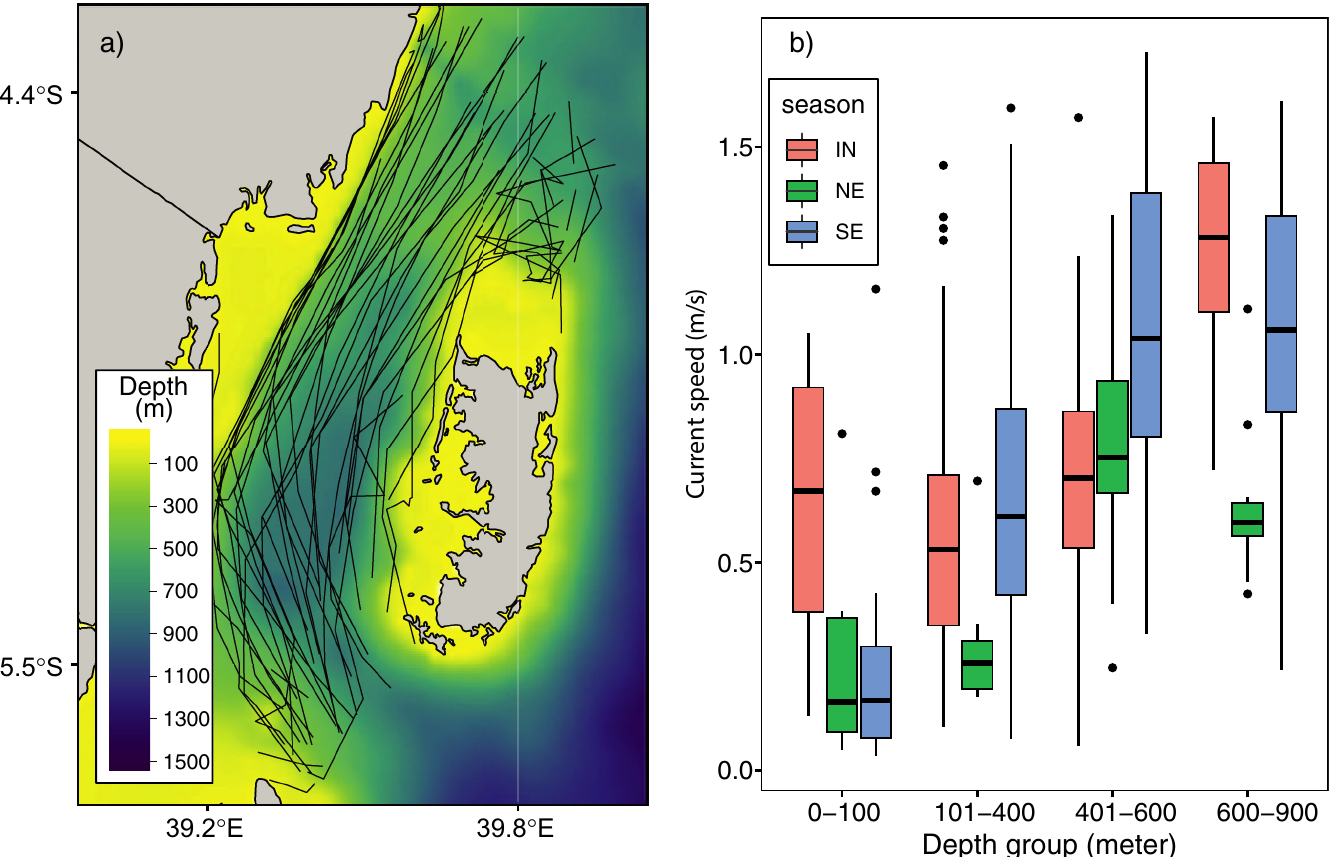
Fig 6. A map of the Pemba Channel showing a) the relationship between the drifter trajectories and bathymetry and b) boxplot showing the surface current velocity at different depth intervals. The black dots in the boxplot indicate outliers.